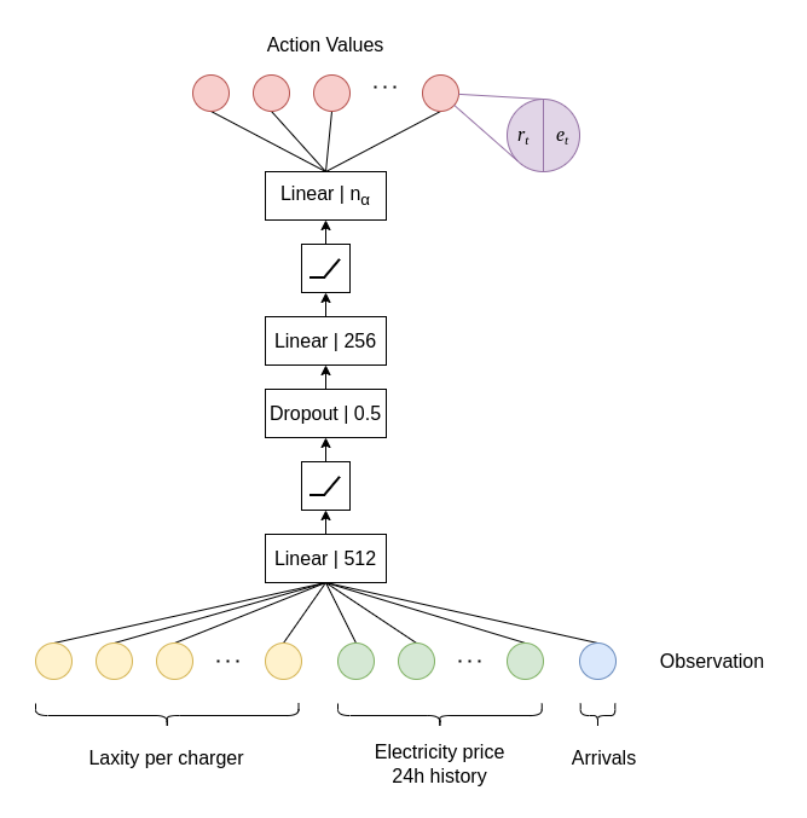
Figure 3. DQN agent